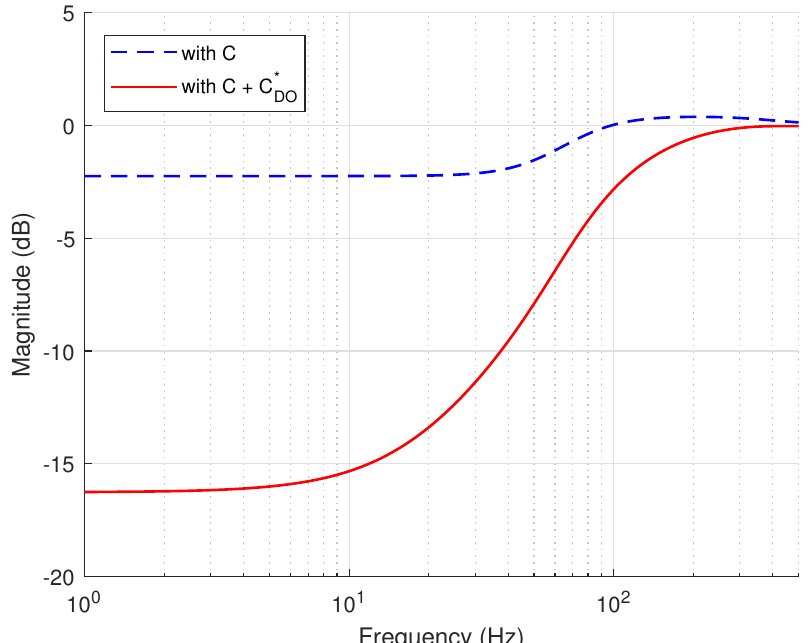
Figure 11. Designed sensitivity